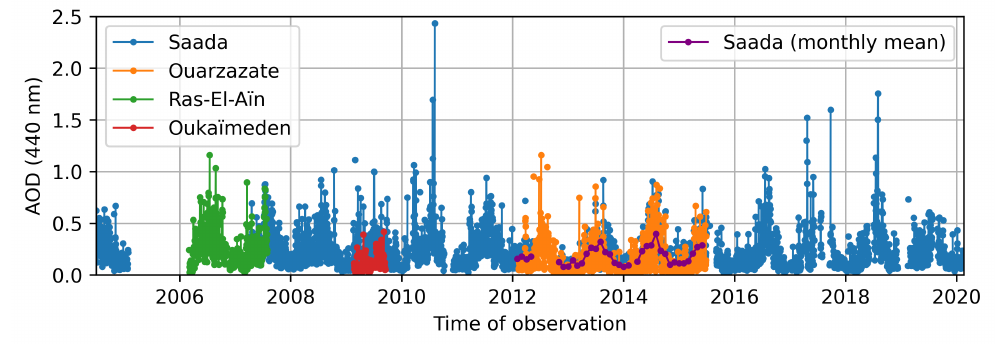
Figure 2. Daily AOD 440 values over Saada (in blue, from 1 July 2004 to 18 February 2020), Ouarzazate (in orange, from 10 February 2012 to 28 June 2015), Ras-El-Aïn (in green, from 4 March 2006 to 31 July 2007) and Oukaïmeden (in red, from 21 February 2009 to 16 September 2009). Monthly AOD 440 values over Saada from 10 February 2012 to 28 June 2015 are represented in